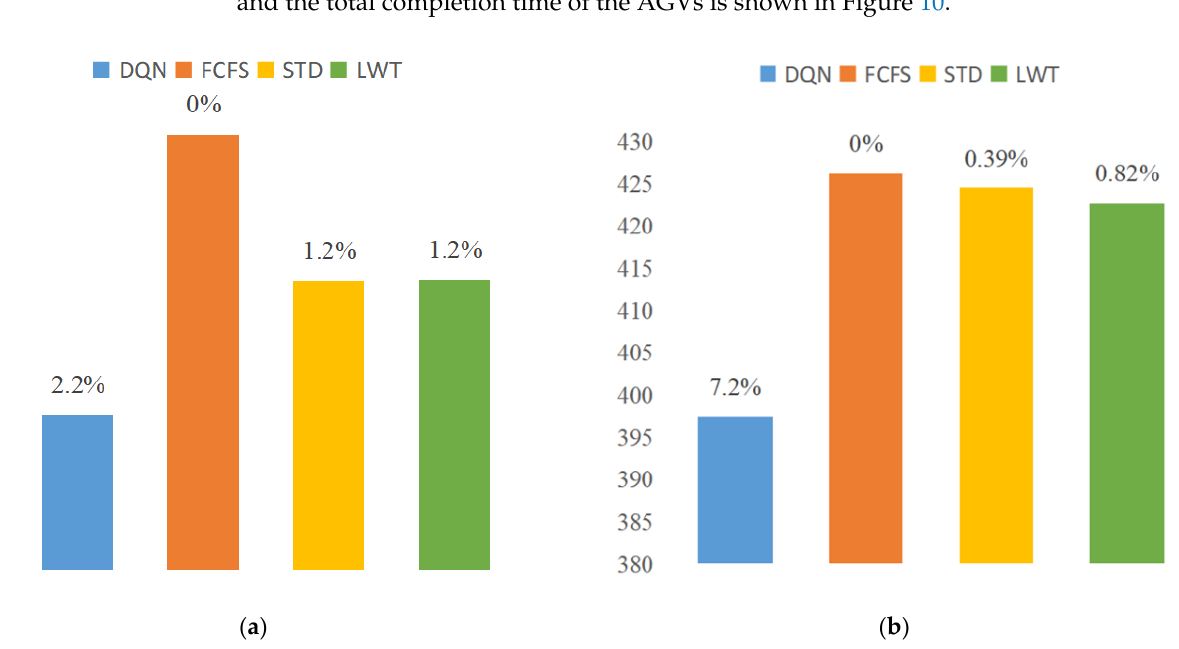
Figure 10. Results comparison: ( a ) improvements in total completion time of AGVs; ( b ) improvements in total waiting time of QCs.